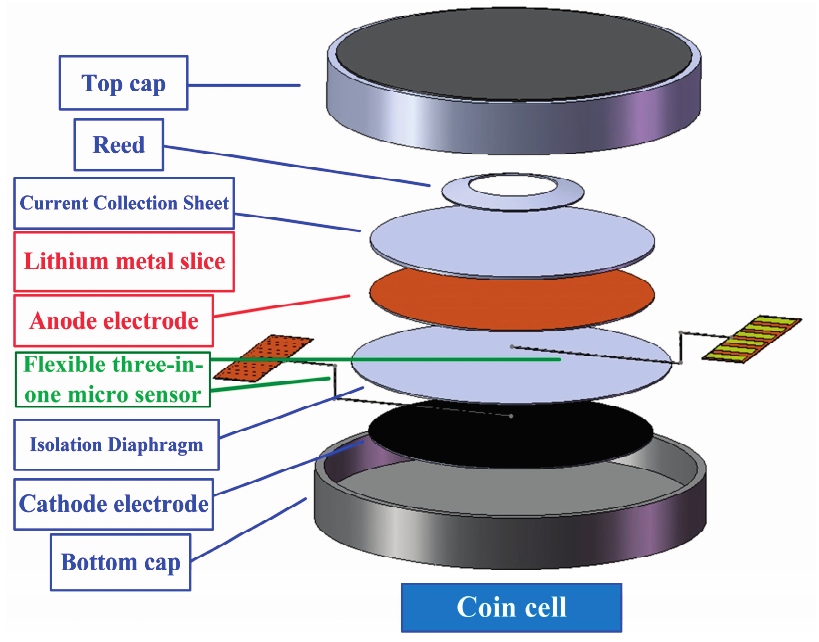
Figure 4. Schematic diagram of the package assembly of the embedded flexible three-in-one microsensors in a coin